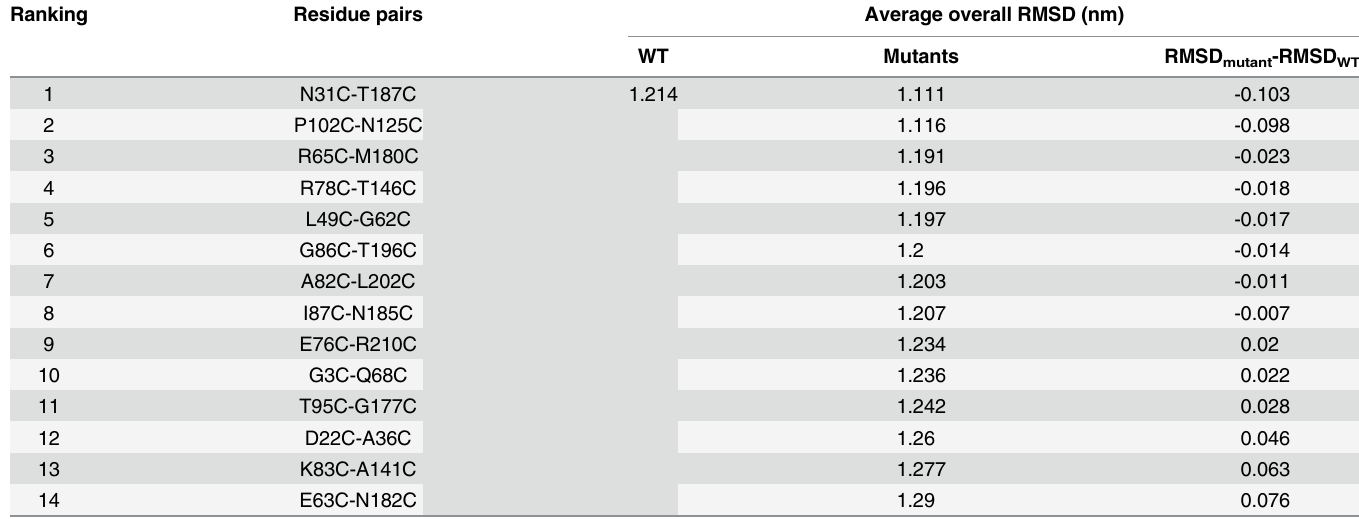
Table 2. Comparison of the average overall RMSD values between wild-type BglTM and the mutants.